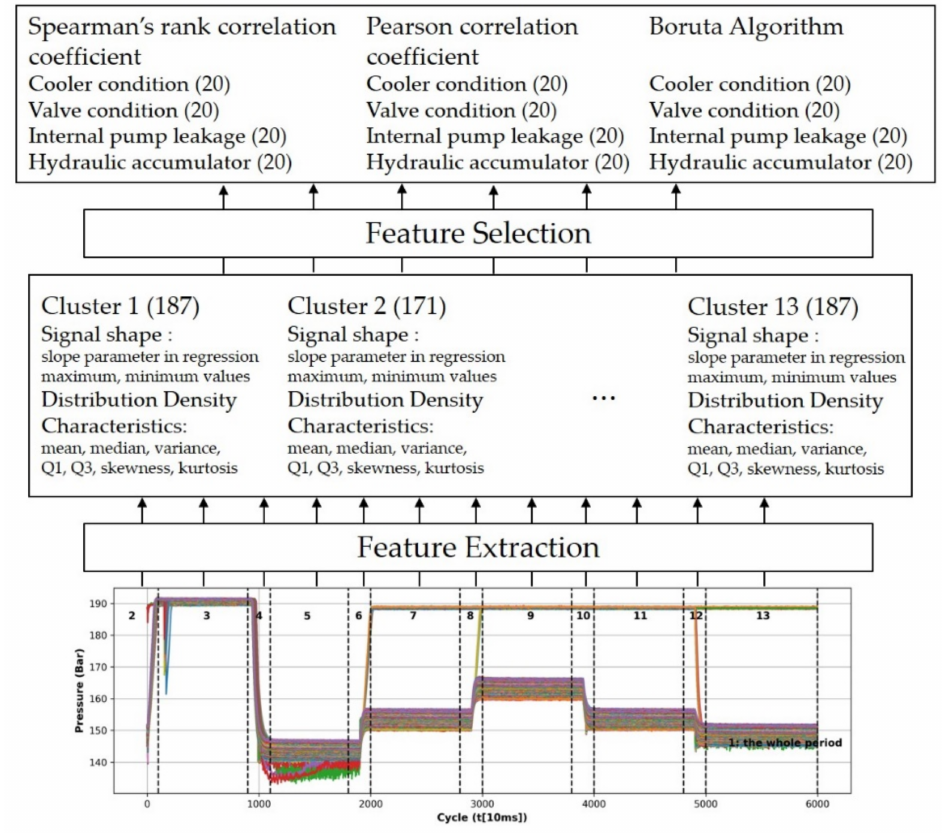
Figure 2. Data pre-processing, feature extraction, and feature selection for machine learning.